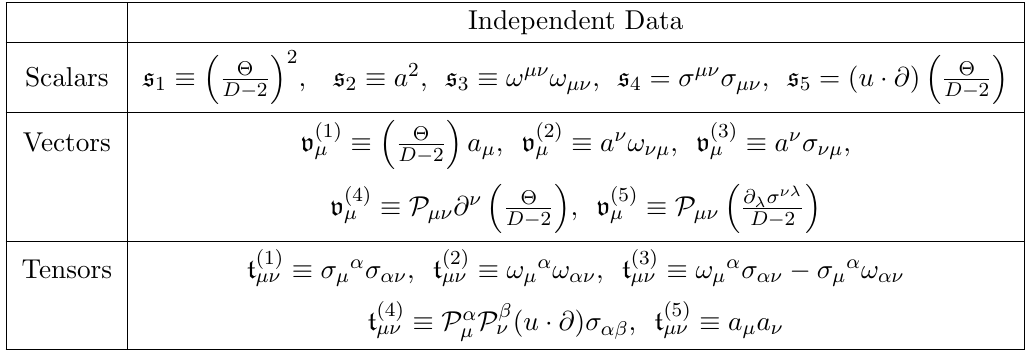
Table 2 . Data at 2nd order in